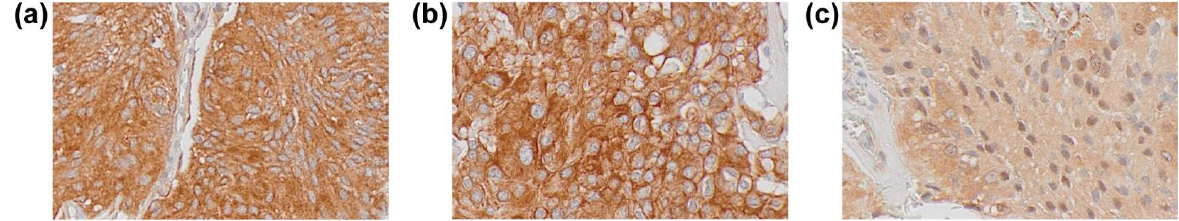
Figure 1. Different immunoreactivities demonstrated for SSTR1: ( a ) cytoplasmatic immunoreactivity; ( b ) membranous immunoreactivity; ( c ) nuclear immunoreactivity (×20).